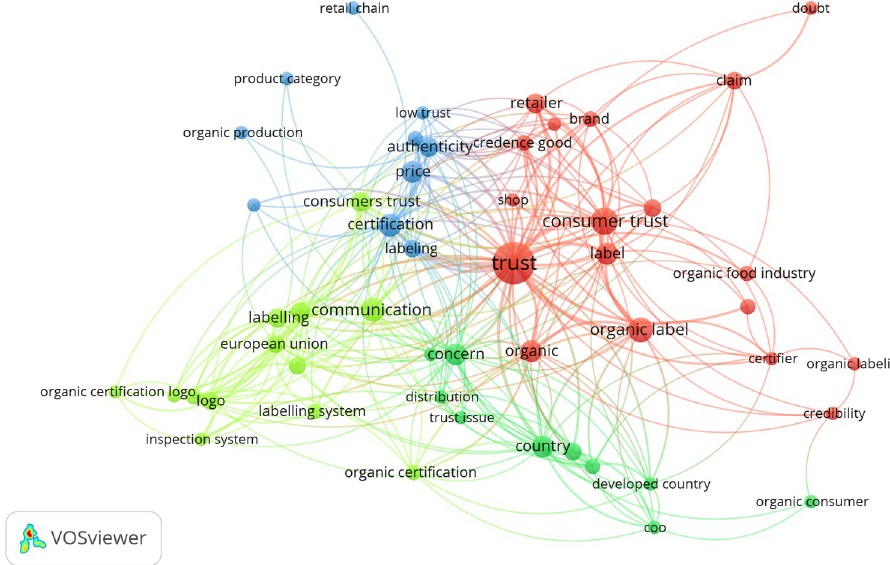
Fig 3. Network visualization of credibility